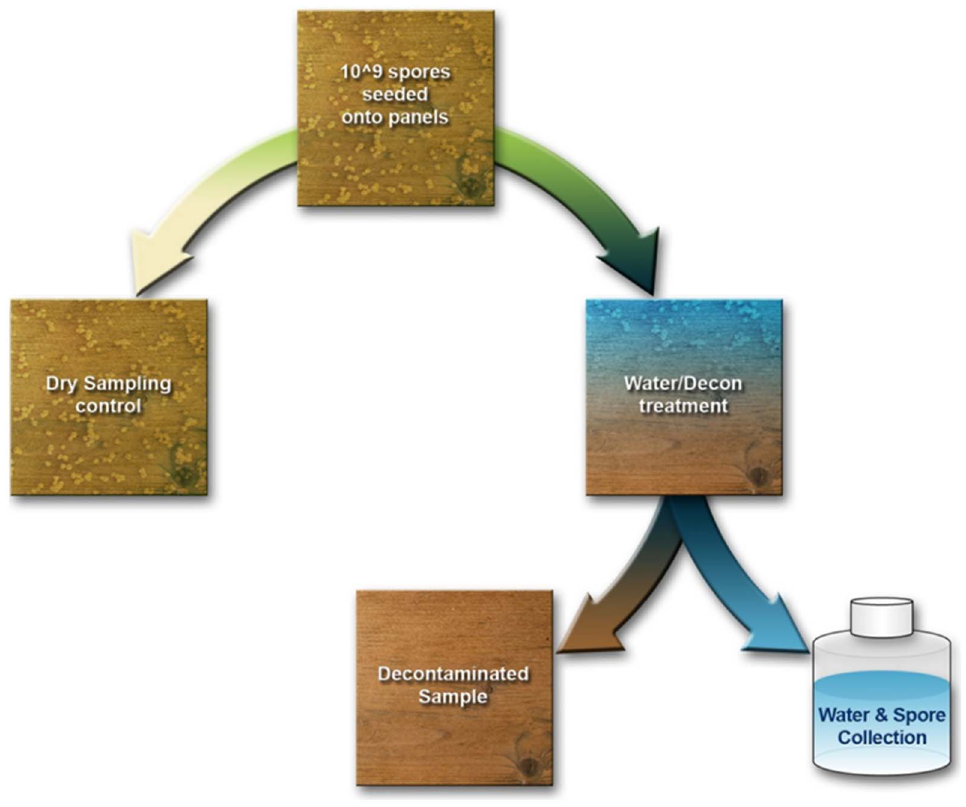
Figure 2. Panel holder for decontamination application.